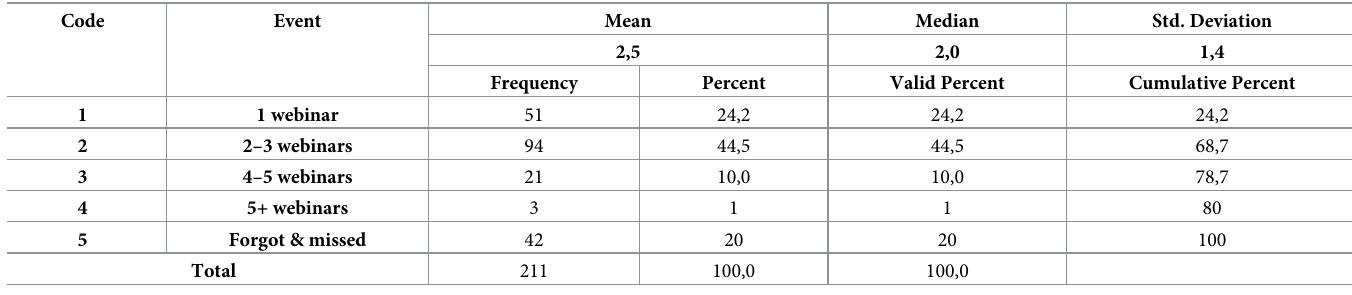
Table 11. Number of remembered webinars